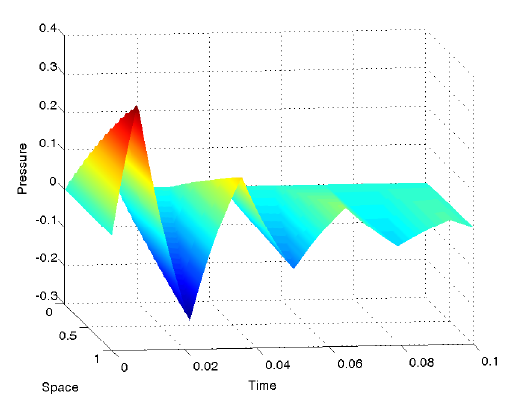
Figure 1. An accurate enough approximation for pressure obtained truncating the series of the analytical solution in a particular case kπ (cid:112) ρ ( λ + 2 µ ) − 1 > 0.